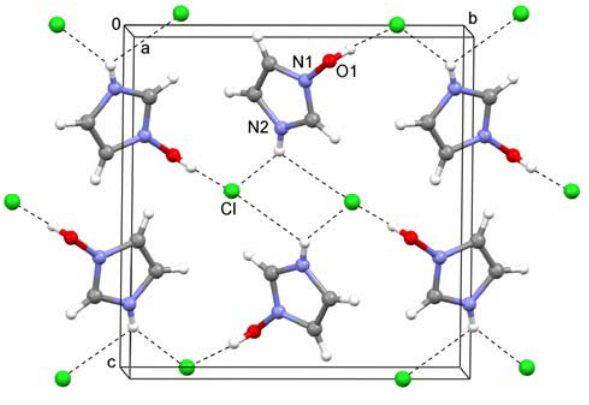
Figure 3. Hydrogen bonding in the crystal structures of ( a ) 1-hydroxyimidazole hydrochloride ( 2 ).